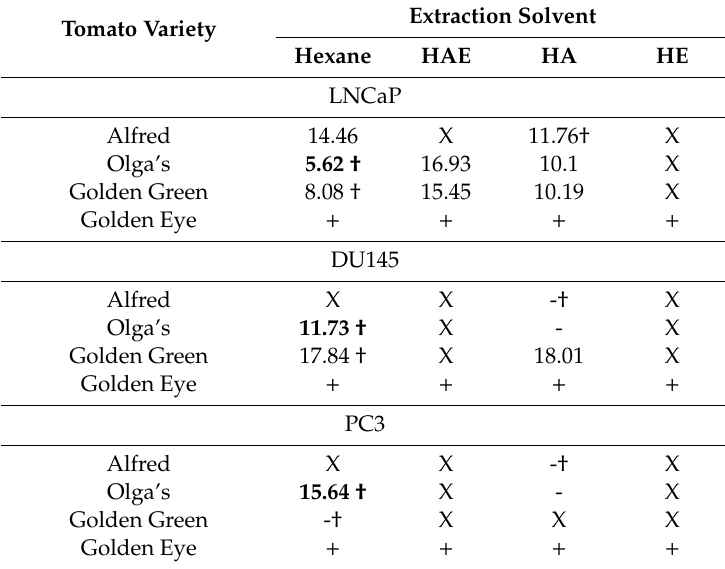
Table 3. IC50 of three prostate cancer cell lines treated with di ff erent tomato extracts. Tomato Variety